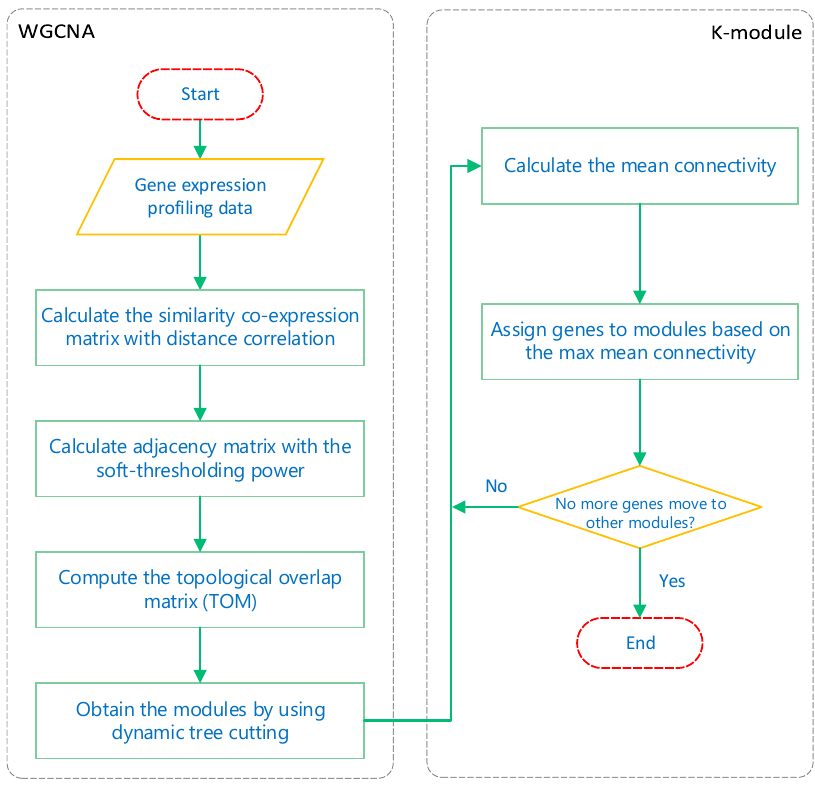
Figure 1. Weighted gene co-expression network analysis (WGCNA) and k-module algorithm flow